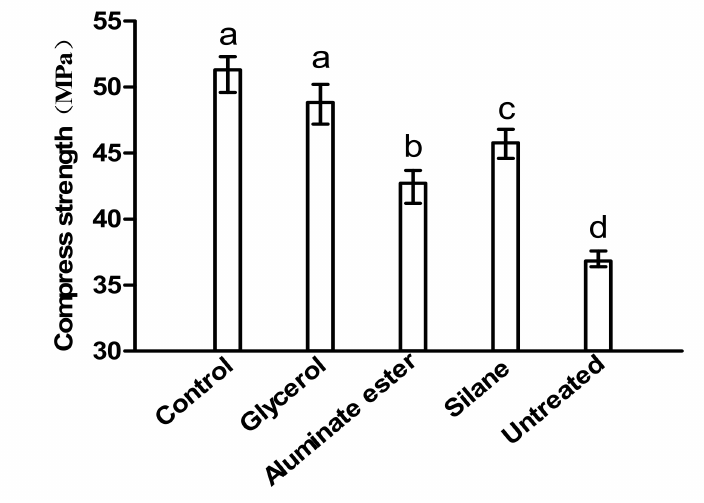
Figure 5. Compressive strength of di ff erent mixtures at 28